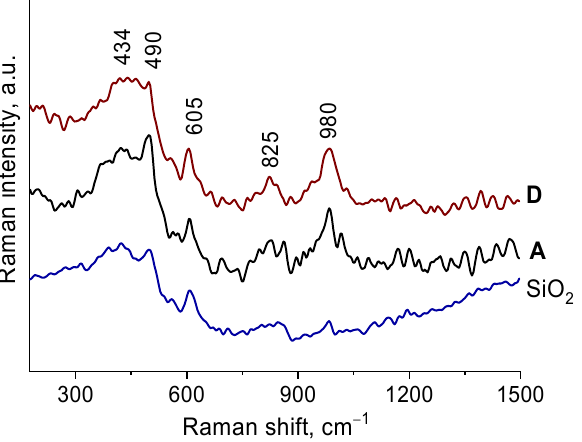
Figure 4. Raman spectra of Zr-EISA samples A and D in comparison with the Zr-free SiO 2 -EISA matrix.